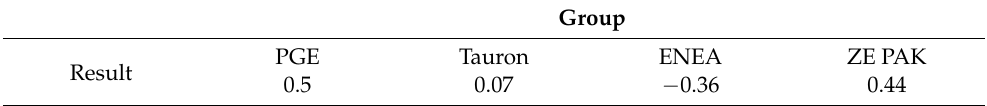
Table 22. Spearman correlation coefficient.